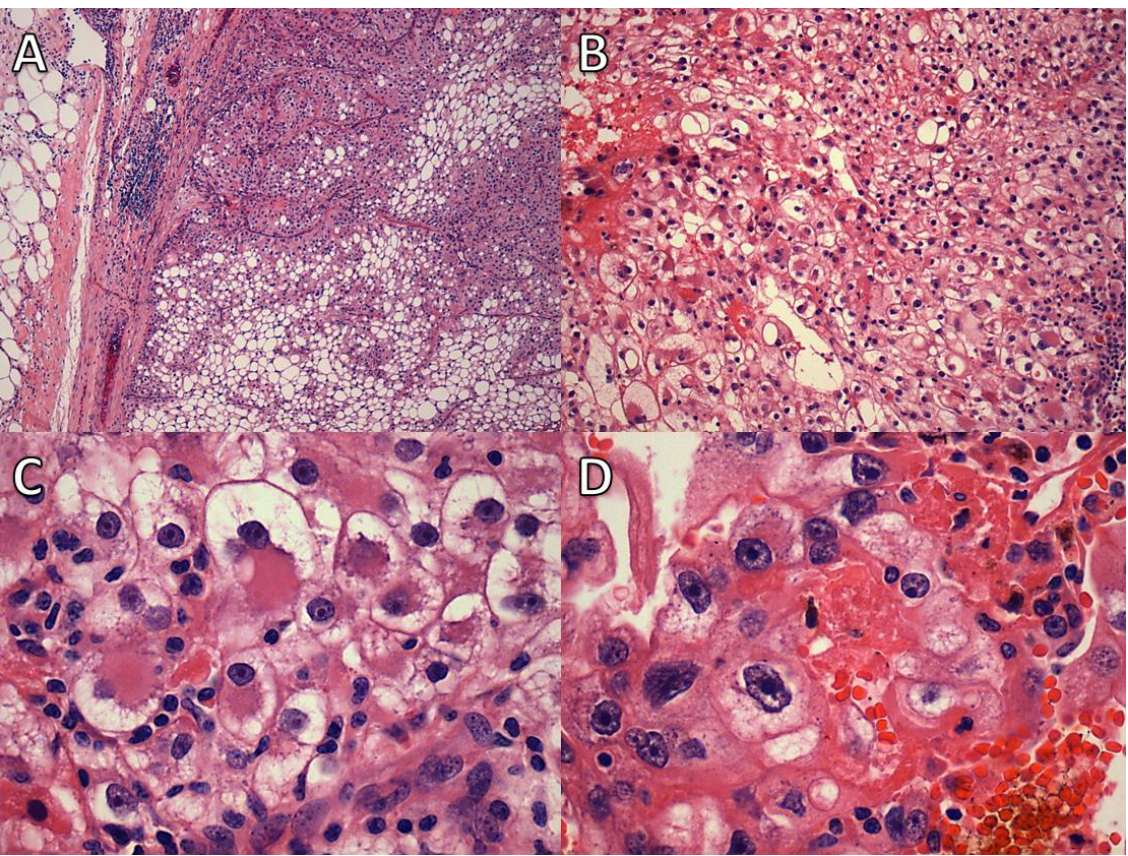
Figure 4. Case 2: A and B . Low-power fields showing clear cell renal cell carcinoma. C . High-power field showing rhabdoid differentiation. D . High-power field showing features consistent with a grade of